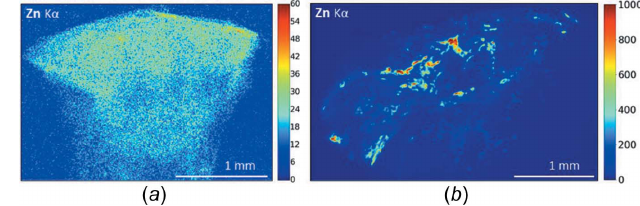
Figure 5 XRF maps, spatial distribution of Zn. ( a ) Patient 11, Zn is diffusely present in the skin tissue, co-located with the inflammatory infiltrate, suggesting an endogenous origin. ( b ) Patient 8, Zn is heterogeneously distributed in the skin tissue, with many intense areas of high Zn concentration, co-localized to the tattoo pigment, suggesting exogenous origin.